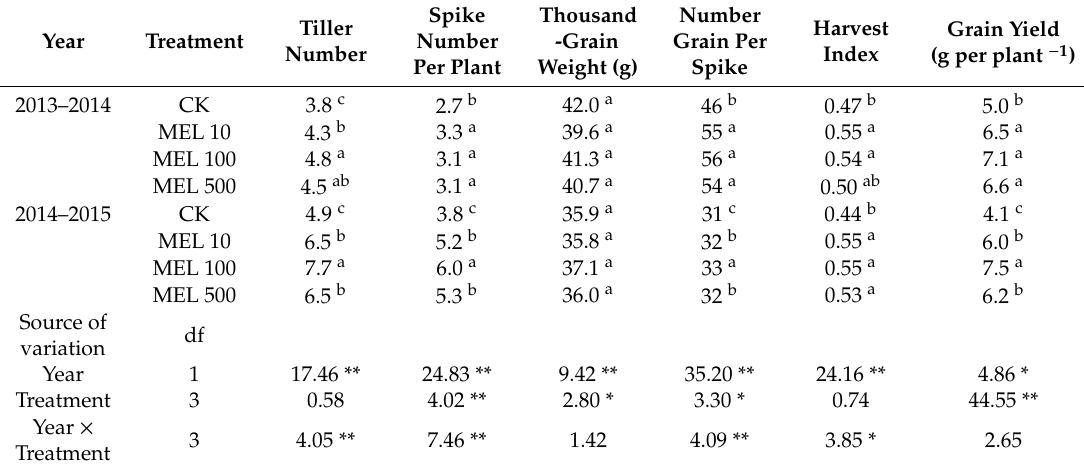
Table 1. The e ff ects of MEL application on tiller number, spike number per plant, thousand-grain weight, grain number per plan, harvest index and grain yield per plant in pot experiment during 2013 to 2015 growing season.